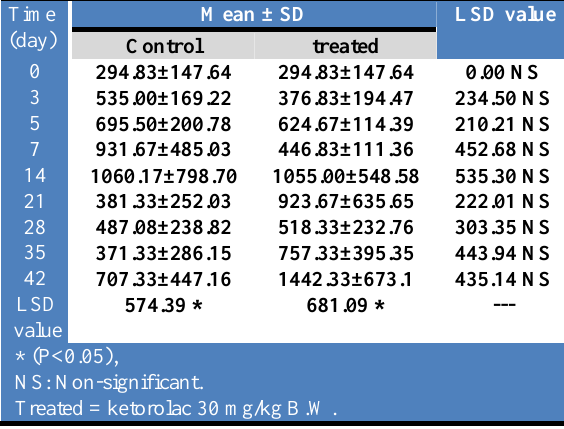
Table, 7: Shows Platelets (× 10*9 /L) in control and ketorolac treated rabbits..